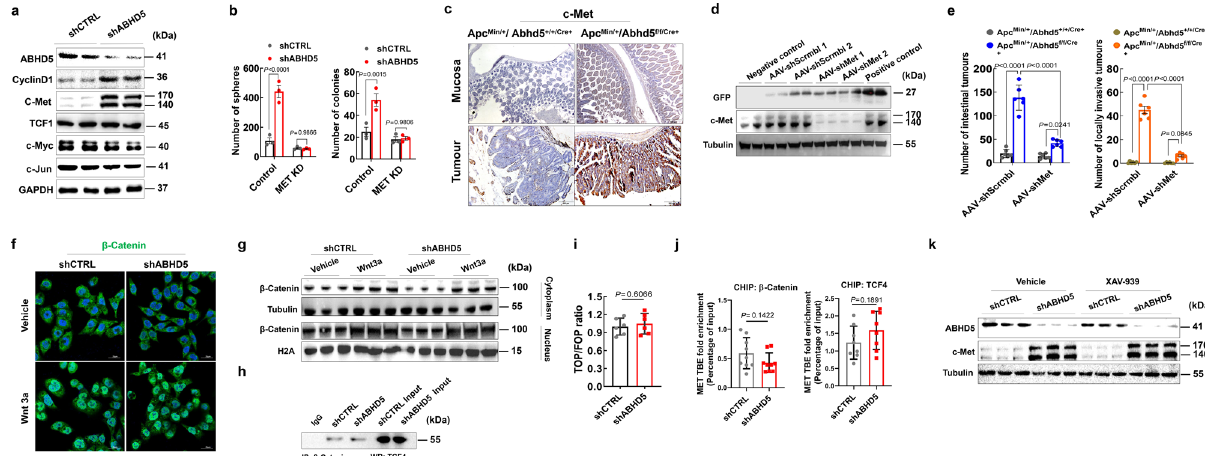
Fig. 3 Loss of ABHD5 promotes c-Met transcription to increase and sustain the stemness of CRC cells independent of β -Catenin. a Immunoblotting of β - Catenin target gene levels in shCTRL or shABHD5 HCT116 cells. b Statistical analyses of sphere formation assay and anchorage-independent growth assay of shCTRL or shABHD5 HCT116 cells transfected with either the control shRNA (Control) or MET- knockdown shRNA ( MET KD) ( n = 3 biologically independent samples). c Representative immunohistochemistry images of c-Met in the intestine tumours and intestine mucosa of Apc Min/ + /Abhd5 + / + /Cre + or Apc Min/ + / Abhd5 f/f/Cre + male mice at 100 days of age. Scale bar, 500 μ m and 200 μ m. d Immunoblotting of GFP and c-Met expression levels in the intestinal mucosa of Apc Min/ + /Abhd5 f/f/Cre + mice injected with GFP-labelled control (AAV-shScrmbl) or Met- silencing-AAV (AAV-shMet) via the tail vein (iv1 – 2: tail vein injection in 2 mice). e Statistical analysis of the number of total and locally invasive tumours in the entire small intestine of control and Apc Min/ + /Abhd5 f/f/Cre + mice injected with control (AAV-shScrmbl) or Met- silencing-AAV (AAV-shMet) via the tail vein ( n = 6 mice/group). f Immuno fl uorescent staining of β -Catenin in shCTRL or shABHD5 HCT116 treated with either Wnt3a (250ng/ml) or vehicle (PBS). g Subcellular fractionation immunoblotting of cytoplasmic and nuclear β - Catenin in shCTRL or shABHD5 HCT116 cells treated with either Wnt3a (250ng/ml) or vehicle (PBS). h β -Catenin immune complexes were immuno precipitated from shCTRL or shABHD5 HCT116 cells and subjected to immunoblotting of TCF4. i Top- fl ash (Wnt/ β -Catenin pathway-responsive fi re fl y luciferase plasmid) reporter gene assay in shCTRL or shABHD5 HCT116 cells ( n = 6 biologically independent samples). j β -Catenin or TCF4 immune complexes were isolated from shCTRL or shABHD5 HCT116 cells and subjected to ChIP-qPCR analysis with primers derived from the promoter regions of MET ( n = 9 (left) or 8 (right) biologically independent samples). k Immunoblotting of ABHD5 and c-Met expression levels in shCTRL or shABHD5 HCT116 cells treated with either XAV-939 (10 μ M) or vehicle (DMSO) (Data are shown as mean±s.e.m. Unpaired two-sided Student ’ s t test was used in panels ( i ) and ( j ), whereas panels ( b ) and ( e ) were analysed using two-way ANOVA and Sidak ’ s multiple comparison test. Source data are provided as a Source Data fi